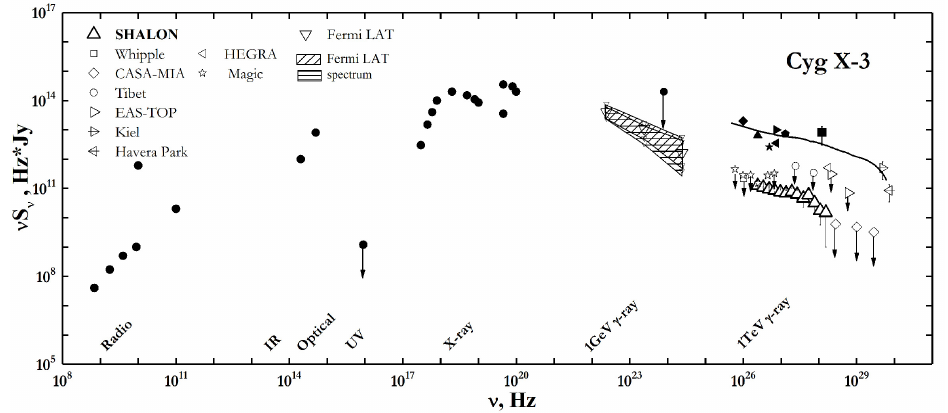
Figure 1. Spectral energy distribution of Cyg X-3 emission from modern and archival observations. (The black solid signs and the curve at TeV energies are the archival data and the model from